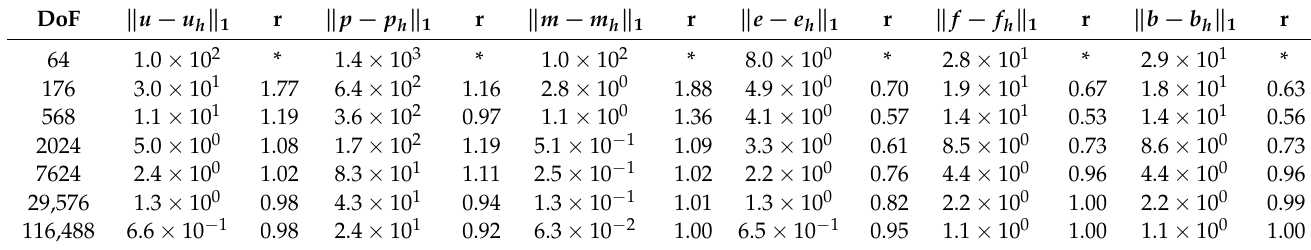
Table 1. Accuracy verification test using continuous and piecewise linear elements for the ap- proximation of all variables. Error history (number of degrees of freedom, errors in the H 1 -norm, and experimental convergence rates) with respect to smooth manufactured solutions computed at t = 10. The symbol ∗ indicates that the convergence rate is not computed for the coarsest